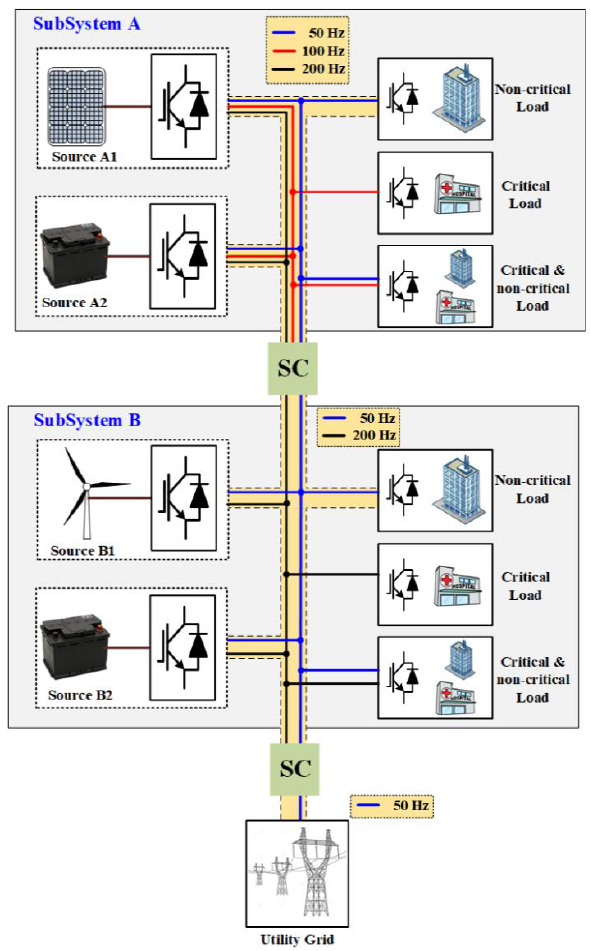
Figure 2. Single-line diagram of the multi-channel-based microgrids.